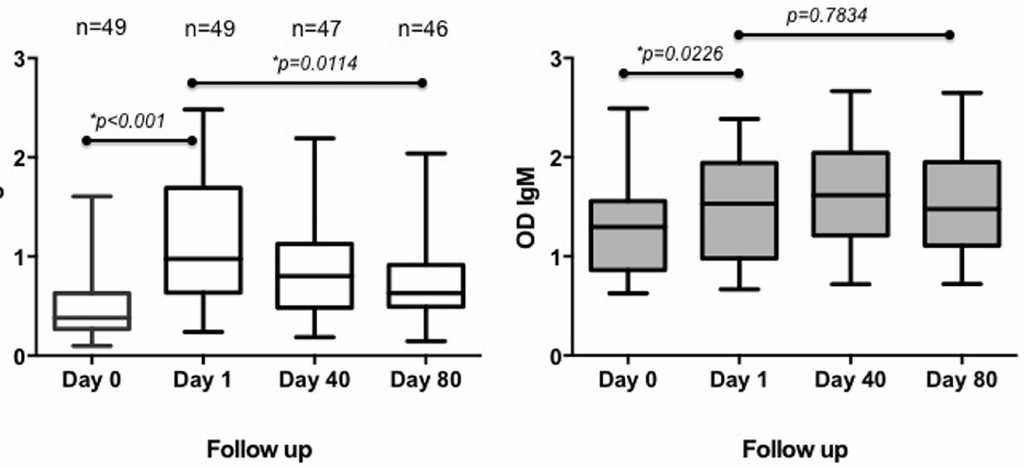
Figure 1. Follow-up study: Concentration of IgG and IgM antibodies of healthy individuals residing in Pamplona during the follow up. Representation in optical densities (OD) of the concentration of IgG antibodies against Ae. aegypti mosquito SGE. Statistical significance of Wilcoxon matched-pairs signed rank test represented as (*) p , 0.05.